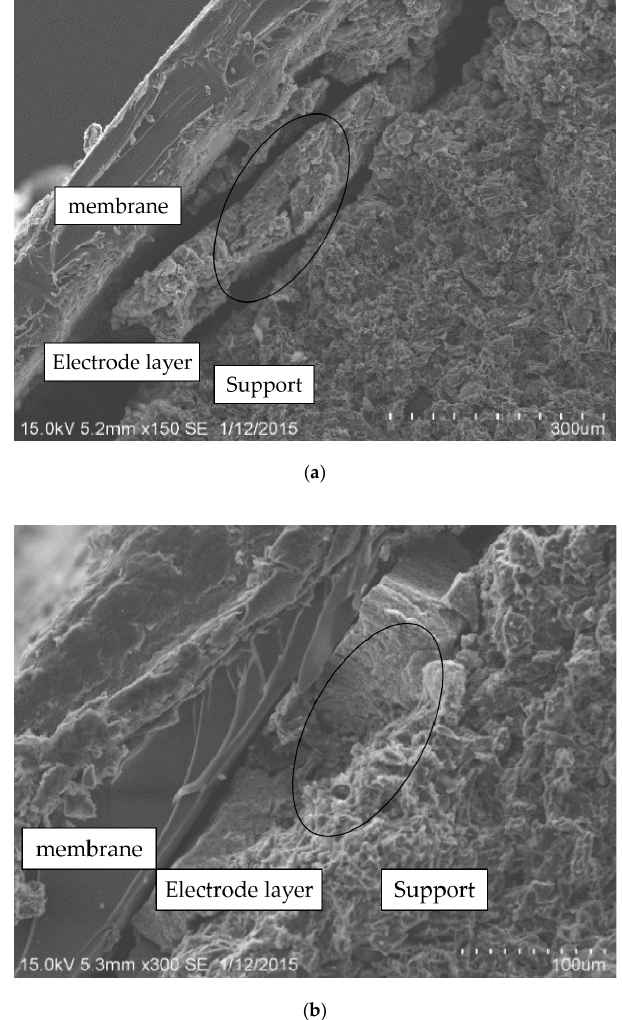
Figure 14. SEM image of electrode cross-section: ( a ) the electrode coated manually ( b ) the electrode coated by self-made